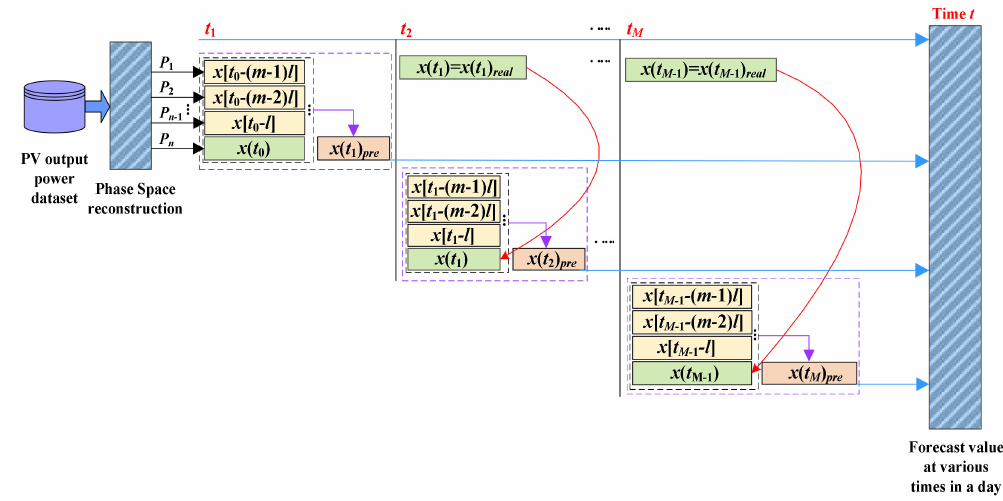
Figure 3. The block diagram of the single-step cyclic scrolling localized prediction